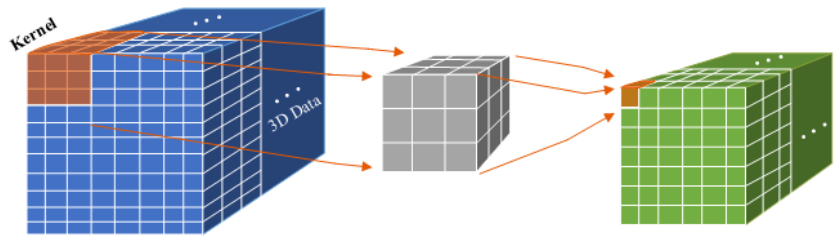
Figure 1. Convolution operation in the 3DCNN architecture [26].